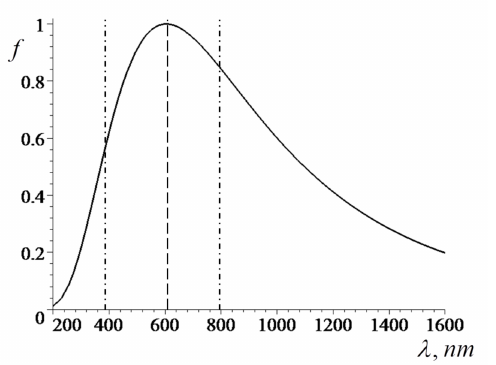
Figure 1. Normalized spectral distribution of a white light source versus wavelength. The visible range is shown by dash–dot lines; the dashed line indicates the maximum for λ = 604